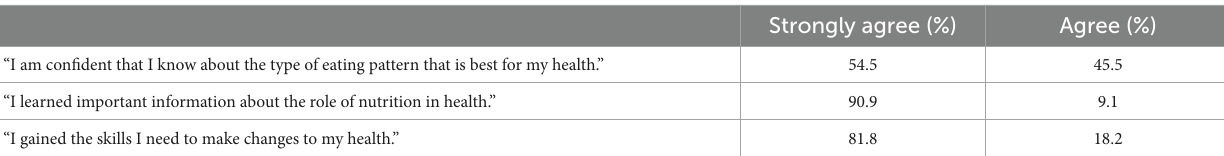
TABLE 4 Participants’ perceptions of program benefit ( n =